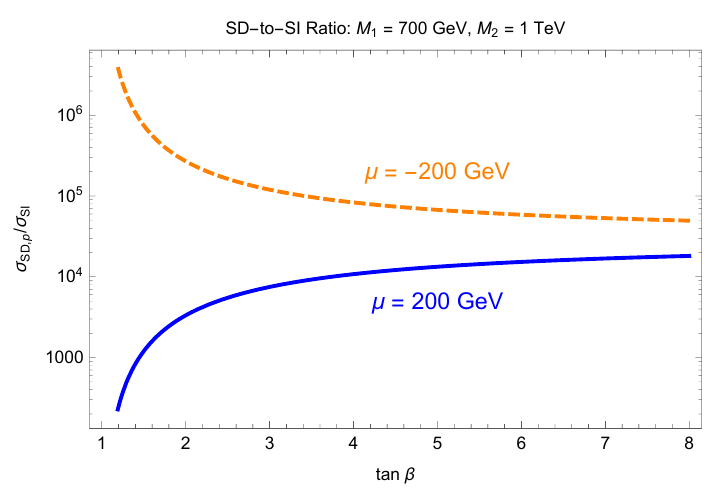
Figure 7 . Contours of the ratio of the spin-dependent scattering cross section on protons, (cid:27) to the spin-independent scattering cross section (cid:27) SI in the ( (cid:22); M 2 ) plane with the choice M 1 = 3 M 2 (as in AMSB). At left, (cid:22) < 0; at right, (cid:22) > 0. Spin-independent scattering rates are larger when (cid:22) is positive. The dashed contours are for tan (cid:12) = 4 and the solid contours for tan (cid:12) = 2. We see that typically the spin-dependent cross section is several thousand times the spin-independent one.